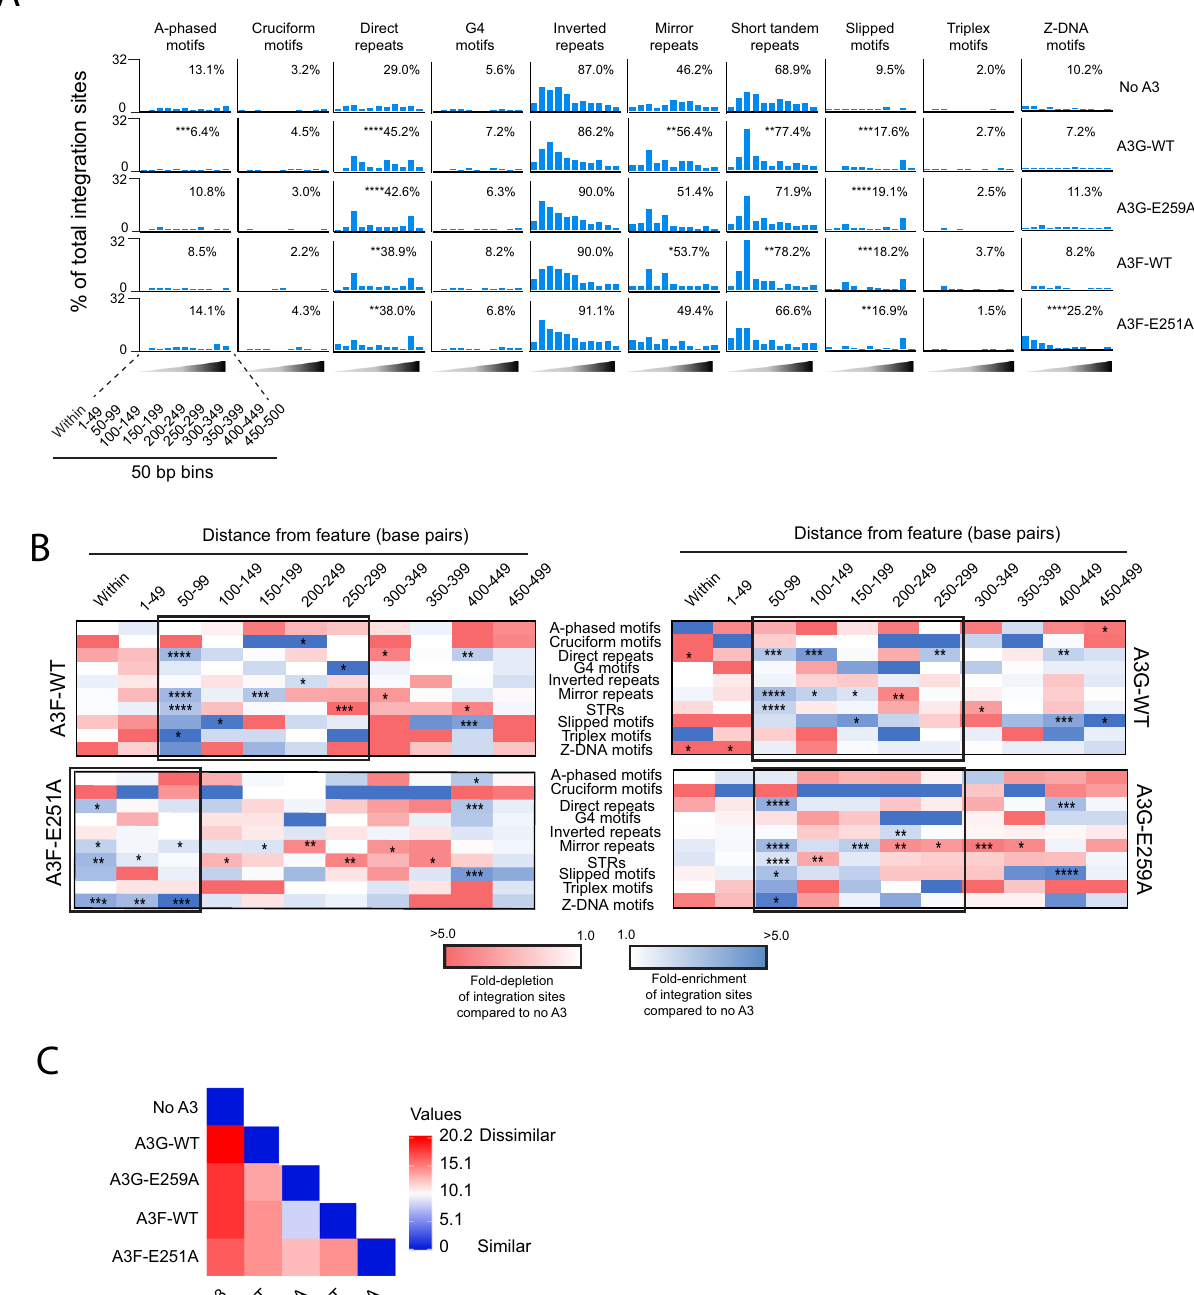
Fig.3|A3FandA3Galtersintegrationsitetargetingofnon-BDNA.A Frequency of integration sites within or in different 50bp distance intervals (1 – 500bp) away fromvariousnon-BDNAfeaturesinCEM-SSTcellsinfectedwithHIV-1generatedin the presence of A3F-WT, A3F [E251A], A3G-WT, or A3G [E259A], or the absence of A3G or A3F ( ‘ no A3 ’ control). The inset numbers refer to the percentage of total integration sites falling within 500bp of the feature. The statistical comparison is with respect to ‘ no A3 ’ . B Heatmaps depicting the fold-enrichment (blue shading) and depletion (red shading) of integration sites at various distance intervals com- pared to the ‘ no A3 ’ control virus. Black boxes highlight regions of notable